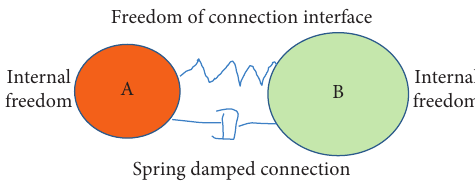
Figure 2: The connection interface of dynamic